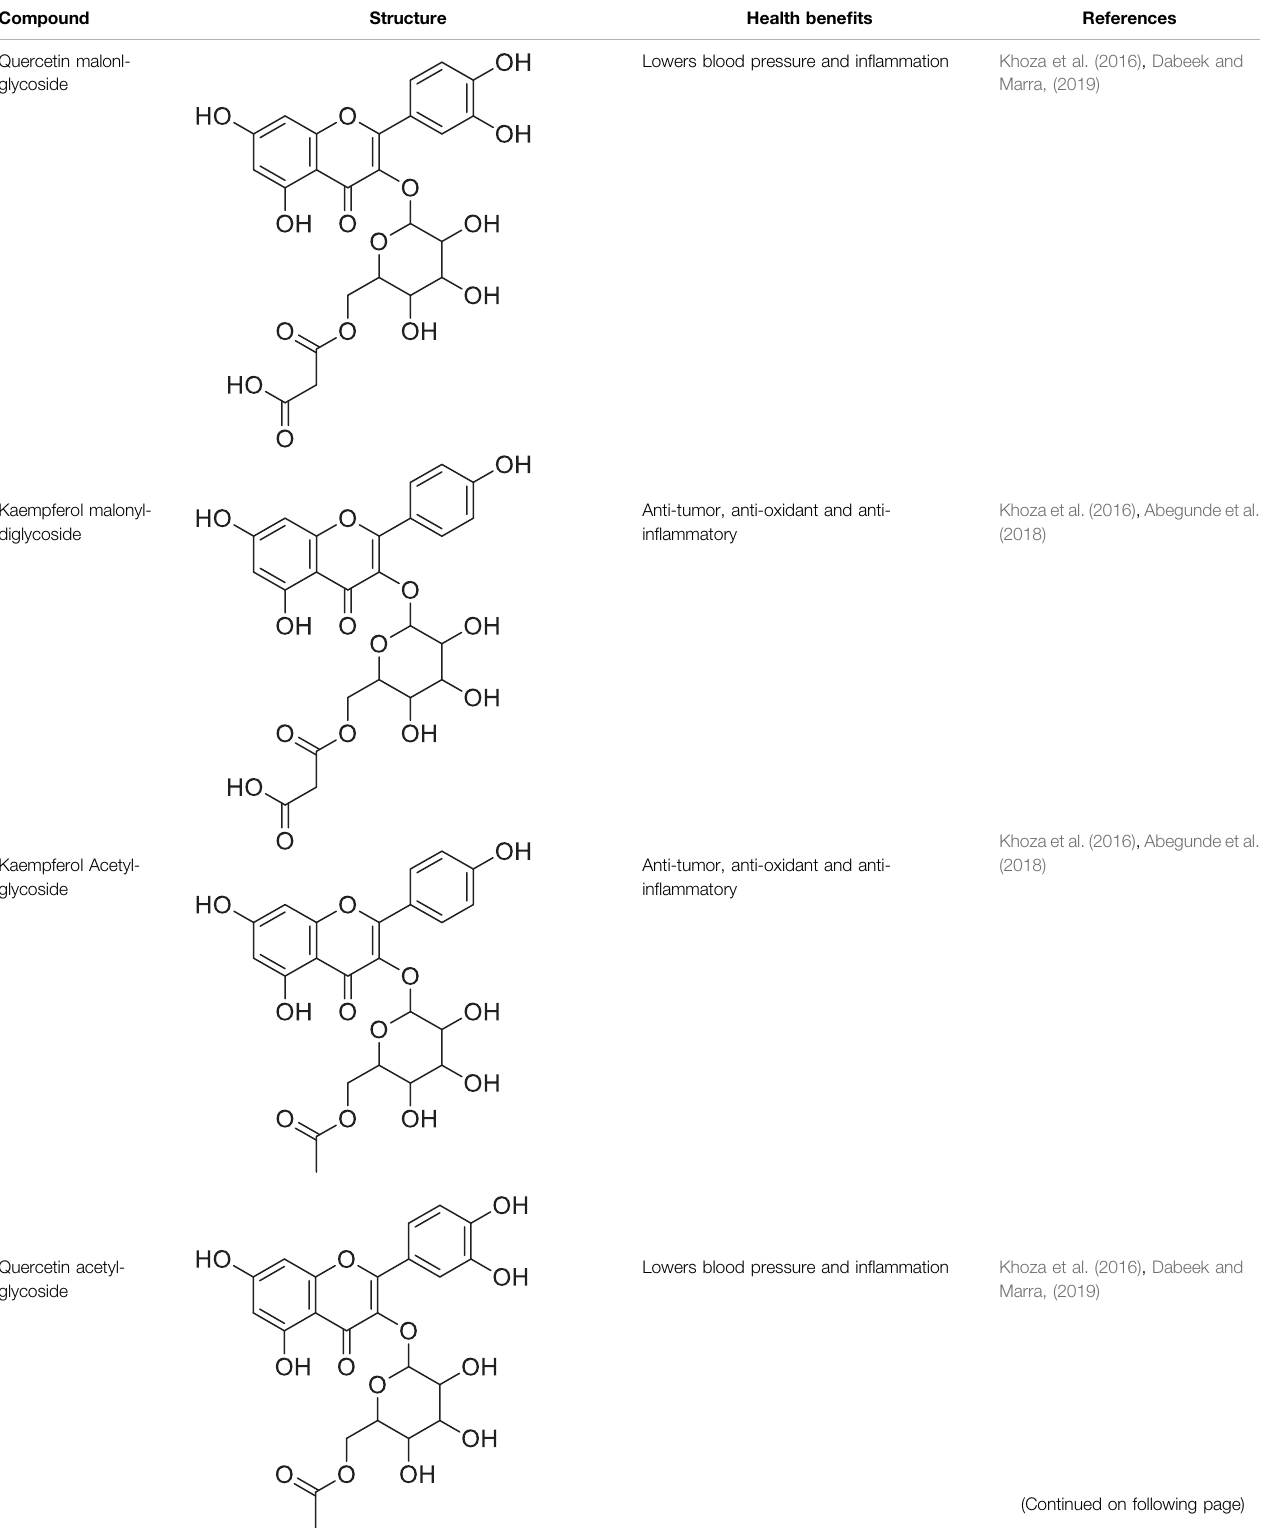
TABLE 2 | Compounds extracted from Momordica foetida Schumach. and their health bene fi